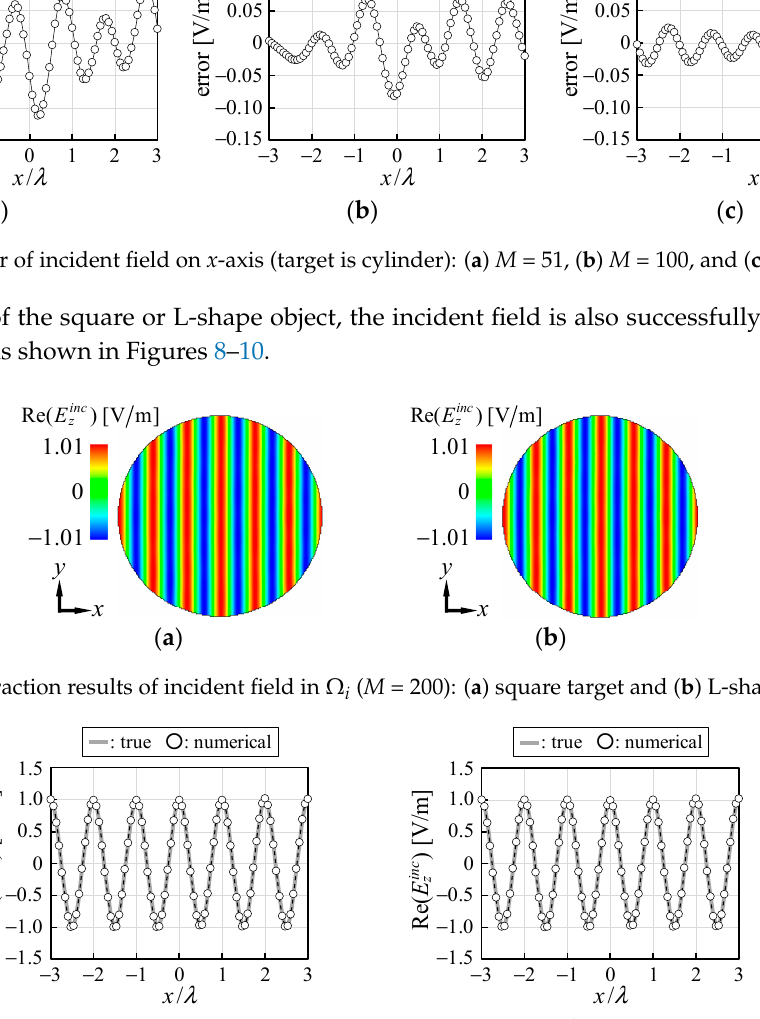
Figure 9. Distributions of incident field on x -axis ( M = 200): ( a ) square target and ( b ) L-shape target.